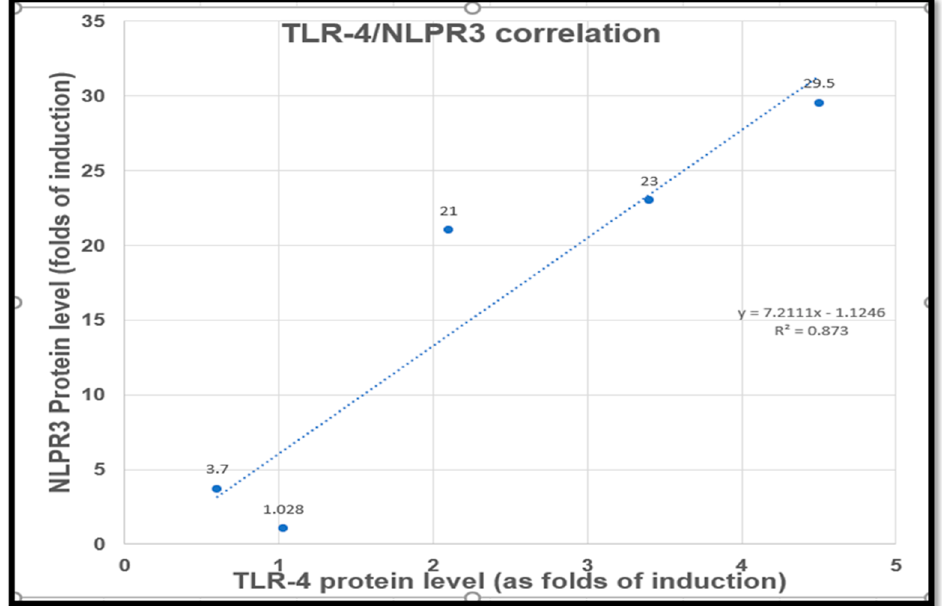
Figure 6. Correlation of TLR4 and NLPR3 protein expression. TLR4: Toll-4 receptors, NLPR3: In- flammasomes.